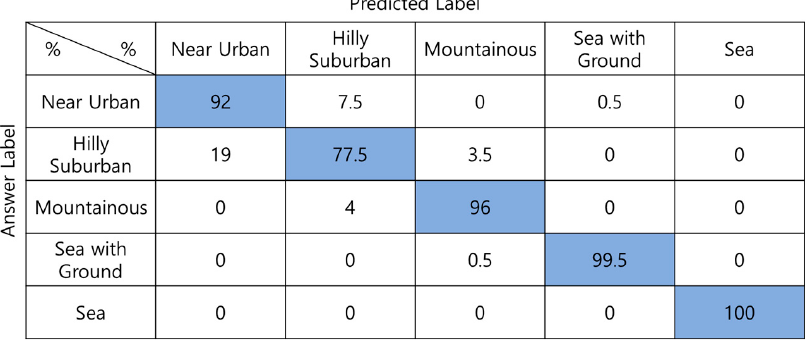
Figure 7. Confusion matrix of DNN-based one-step classification.